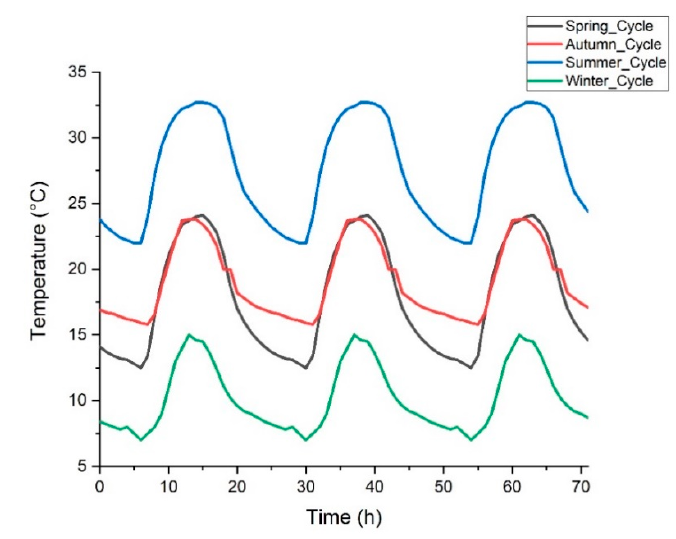
Figure 4. Temperature programs used to simulate the di ff erent season of the